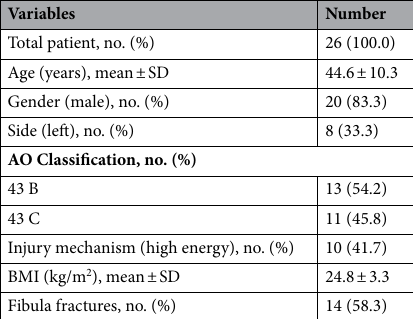
Table 1. Patient demographic data and fracture characteristics. Abbreviation: SD standard